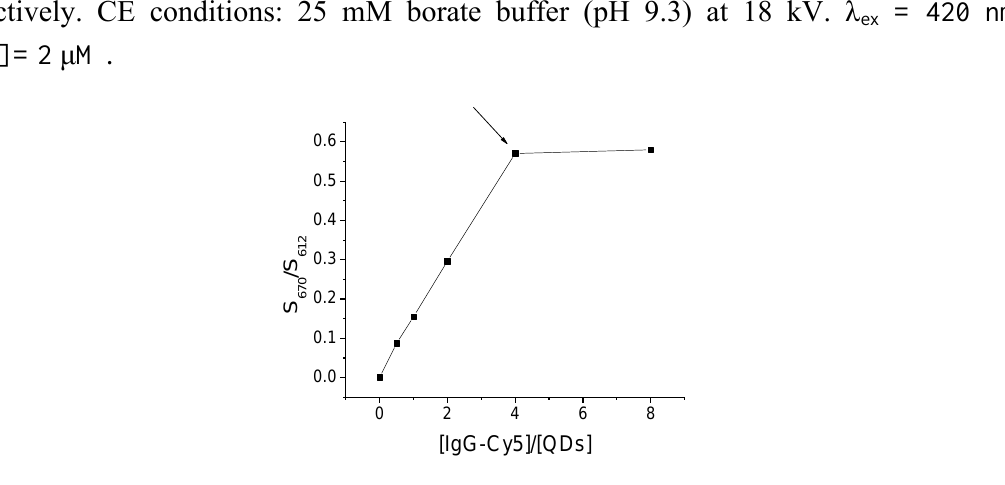
and S are 670 612 = 420 nm. ex